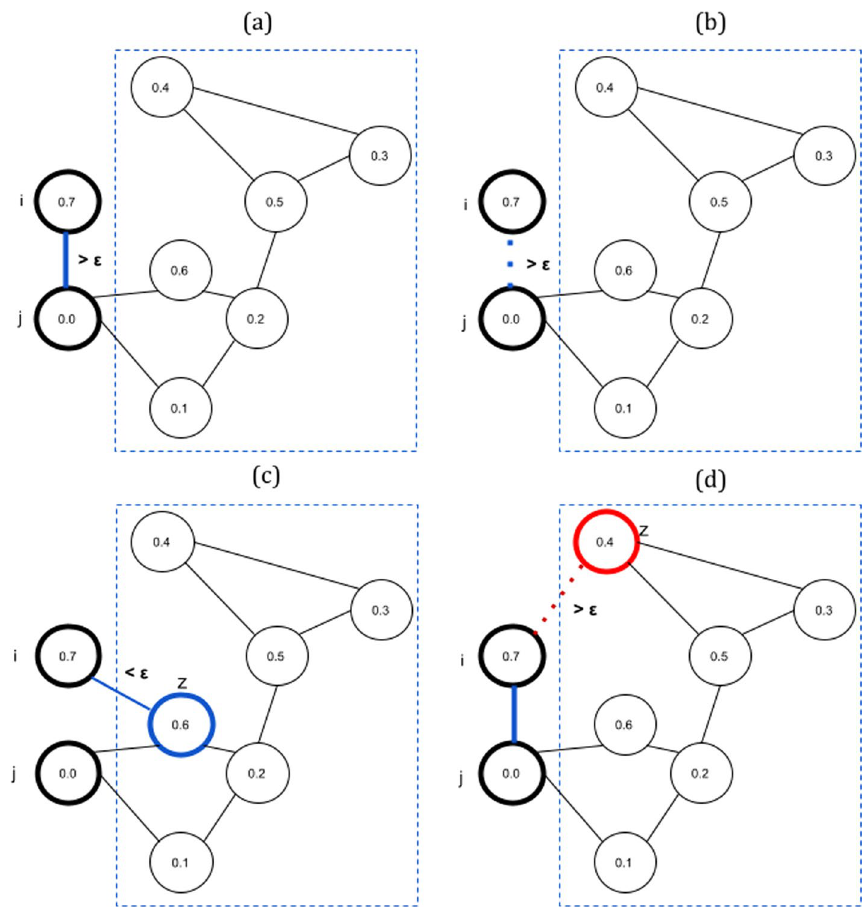
than the confidence bound. For this reason b node i tries to break the arc ( i , j ) and form a new arc ( i , z ) (with probability p r , with probability 1 − p r nothing happens). Node z is chosen randomly between the remaining nodes in the network. In the case that | x i − x z | < ǫ ( c ) the arc ( i , j ) is broken and the arc ( i , z ) is formed. Otherwise, if | x i − x z | ≥ ǫ ( d ), the rewiring fails, and the network structure remains the